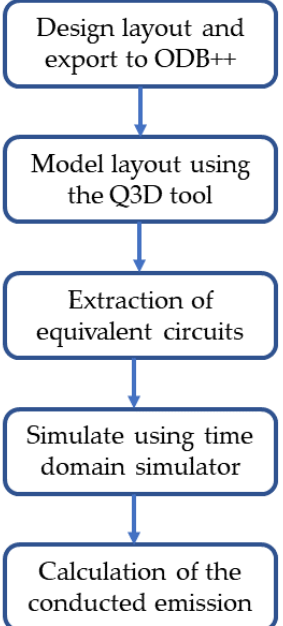
Figure 1. Workflow for conducted emission proposed by [6].